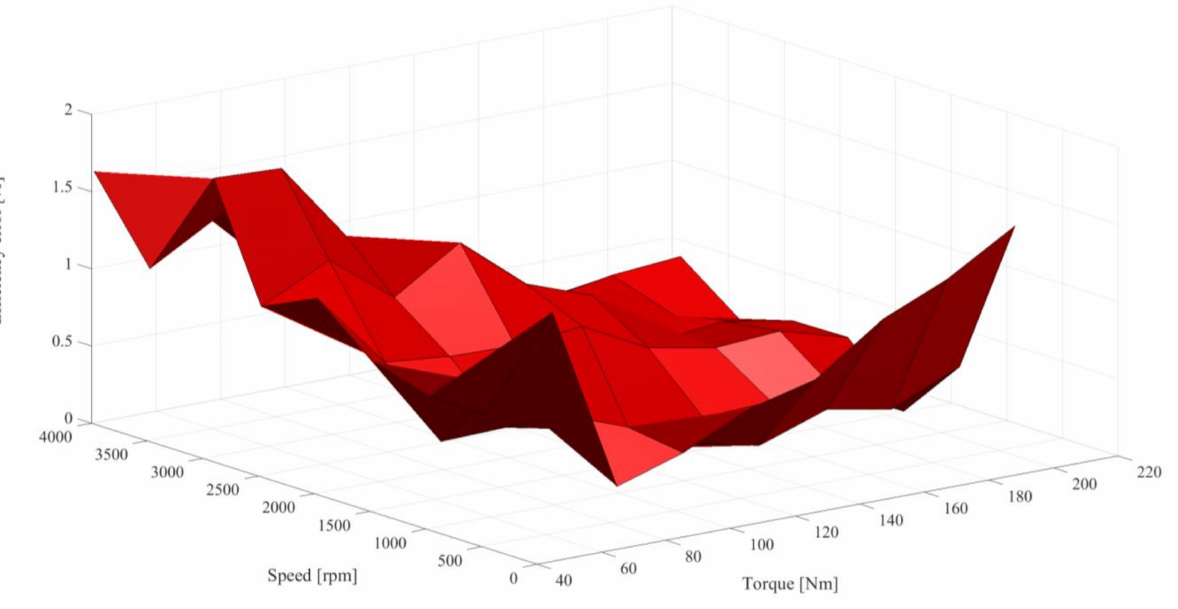
Figure 3. Three-dimensional representation of the efficiency error (measured vs. computed) as a function of torque and speed.